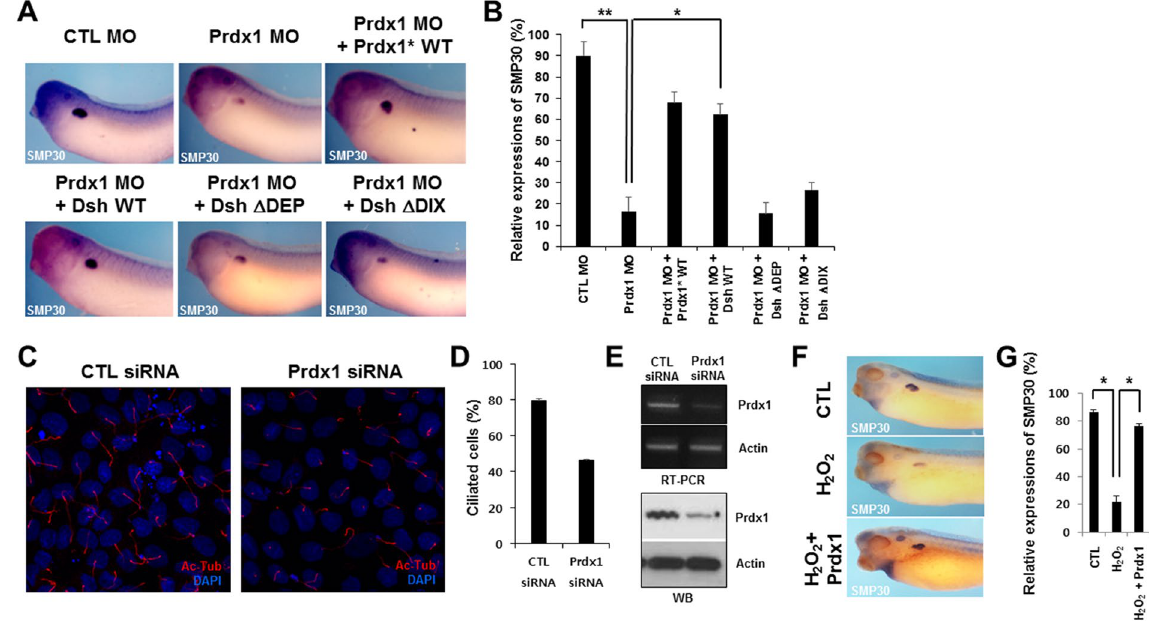
Figure 4. Prdx1 regulates pronephrogenesis via the Wnt signaling pathway by modulating ROS levels in X. laevis embryos. ( A ) prdx1 MOs and WT prdx1 * , WT Dsh (Dsh WT), Dsh Δ DEP , or Dsh Δ DIX were co- injected into both blastomeres of two-cell stage embryos. Embryos at the stage 33 were used for whole-mount in situ hybridization, and proximal tubules in the pronephros were visualized with a smp30 probe. Pronephros development recovered only in embryos co-injected with WT prdx1 * or Dsh WT. ( B ) Graphical demonstration of pronephros development in embryos co-injected with prdx1 MOs and WT prdx1 * , Dsh WT, Dsh Δ DEP , or Dsh Δ DIX . ( C ) MDCK cells were transfected with either 10 nM prdx1 or control siRNAs. Primary cilia were visualized using an acetylated-tubulin (Ac-Tub) antibody. Cell nuclei were stained with DAPI. Numbers of cilia cells were markedly reduced in MDCK cells by prdx1 siRNA mediated knockdown of prdx1 . ( D ) Graphical representation of ciliated cells transfected with control siRNA and prdx1 siRNA. prdx1 knockdown significantly reduced the number of cilia in MDCK cells. ( E ) Specificity of prdx1 knockdown in MDCK cells transfected with Prdx1siRNA was confirmed by RT-PCR examination as well as western blot studies. Significant reduction in levels of prdx1 mRNA and proteins was observed in MDCK cells transfected with Prdx1siRNA. ( F ) Control and prdx1 -injected (200 pg) embryos were treated with 2 μ M H 2 O 2 at stage 8.5. Embryos at the stage 33 were used for whole-mount in situ hybridization, and proximal tubules in the pronephros were visualized with a